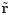
Setups used to learn versatile nonlinear computations with spiking neural networks.(a) A static continuous signal coding spiking neural network (CSN, gray shaded) serves as a spiking computational reservoir with high signal-to-noise ratio. The results of computations on current and past external inputs Ie can be extracted by simple neuron-like readouts. These linearly combine somatic inputs generated by saturating synapses or nonlinear dendrites, r˜ (red), to output signals z (Eqs (13, 14)). The output weights wo are learned such that z approximates the desired continuous target signals. (b) Plastic continuous signal coding spiking neural networks (PCSNs) possess a loop that feeds the outputs z back via static connections as an additional input Ief (blue, Eq (15)). Such networks have increased computational capabilities allowing them to, e.g., generate desired self-sustained activity. (c) The feedback loop can be incorporated into the recurrent network via plastic recurrent connections (red in gray shaded area).